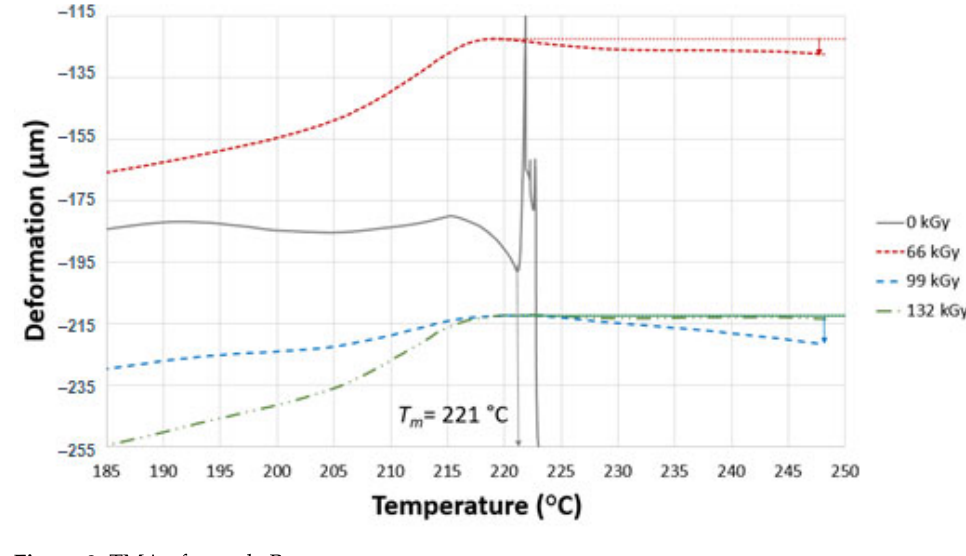
Figure 8. TMA of sample B.